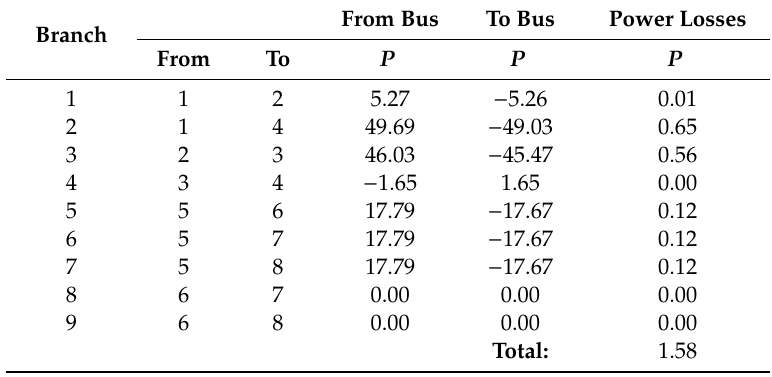
Table A43. Results of the mixed AC / DC PF calculations in Case 7-3. DC branch